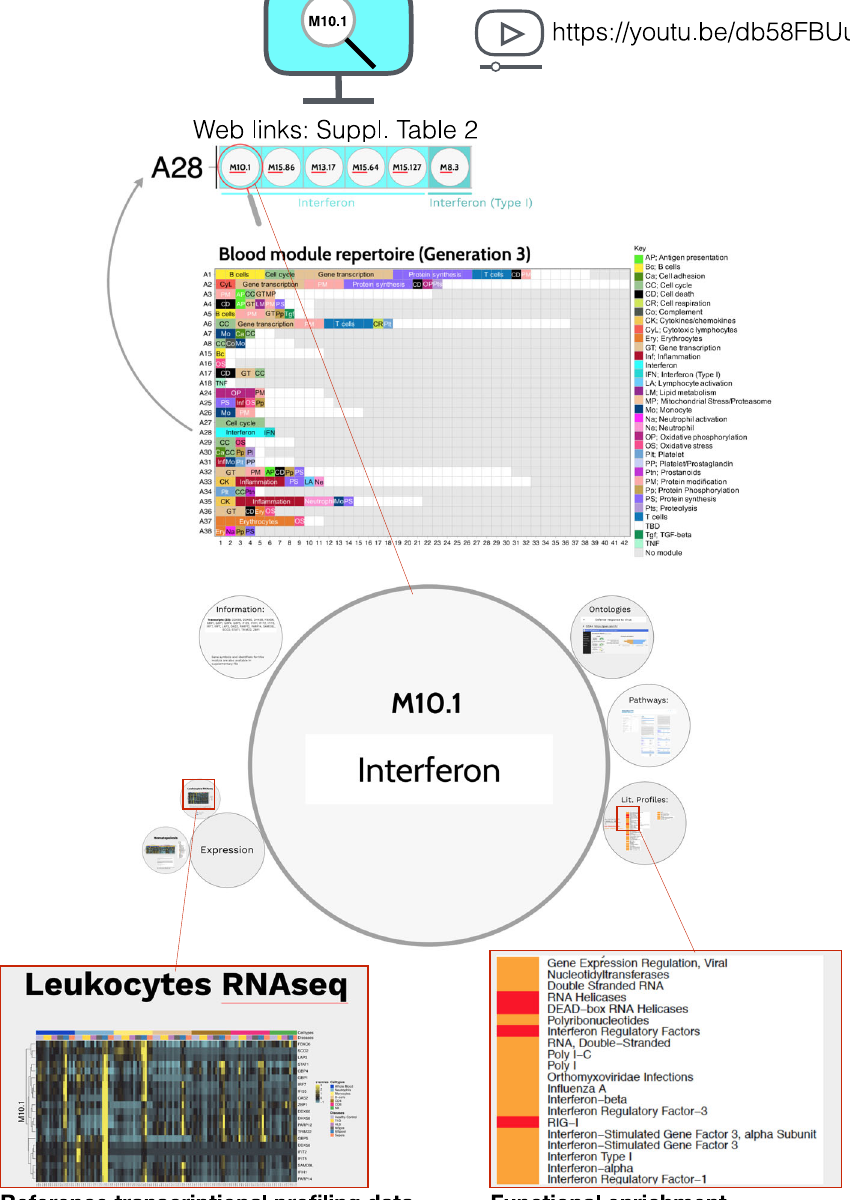
Fig. 4 Functional annotation of the transcriptional module repertoire. An interactive application is available to explore the 382 modules comprising the blood transcriptome repertoire. A gene list, along with the ontology, pathway, literature-term enrichment, and transcriptional pro fi ling data for reference transcriptome datasets (circulating leukocyte populations, hematopoiesis) is provided for each module. Zoom in and zoom out functionalities for close-up examination of the text and fi gures embedded in the presentation are available. Web links providing access to modules within a given aggregate are listed in Supplementary Table 2. For a demonstration video, please visit: